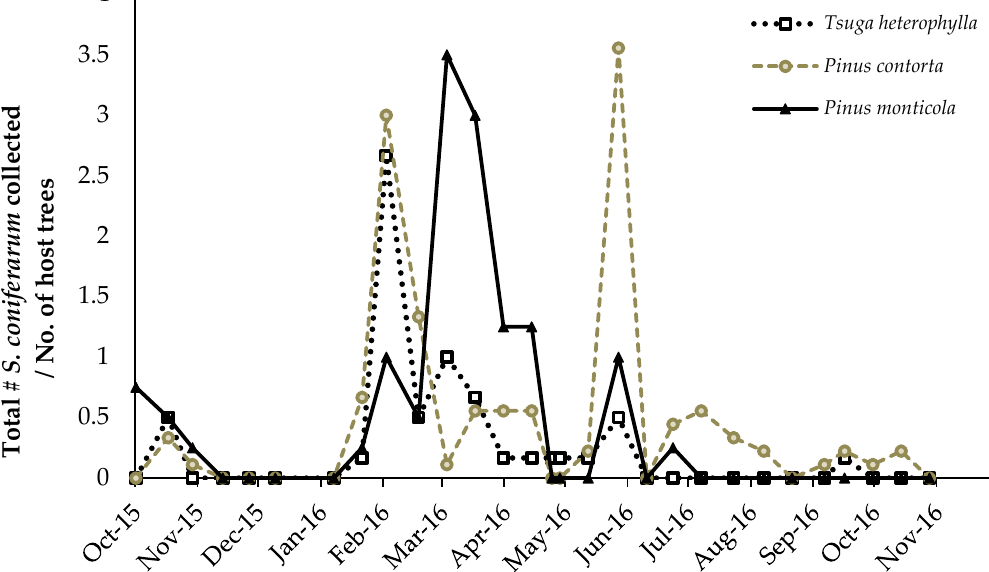
Figure 6. Total Scymnus coniferarum adults collected from each host tree species through beat-sheet analysis (October 2015–November 2016). No beetles were recovered from Pseudotsuga menziesii .